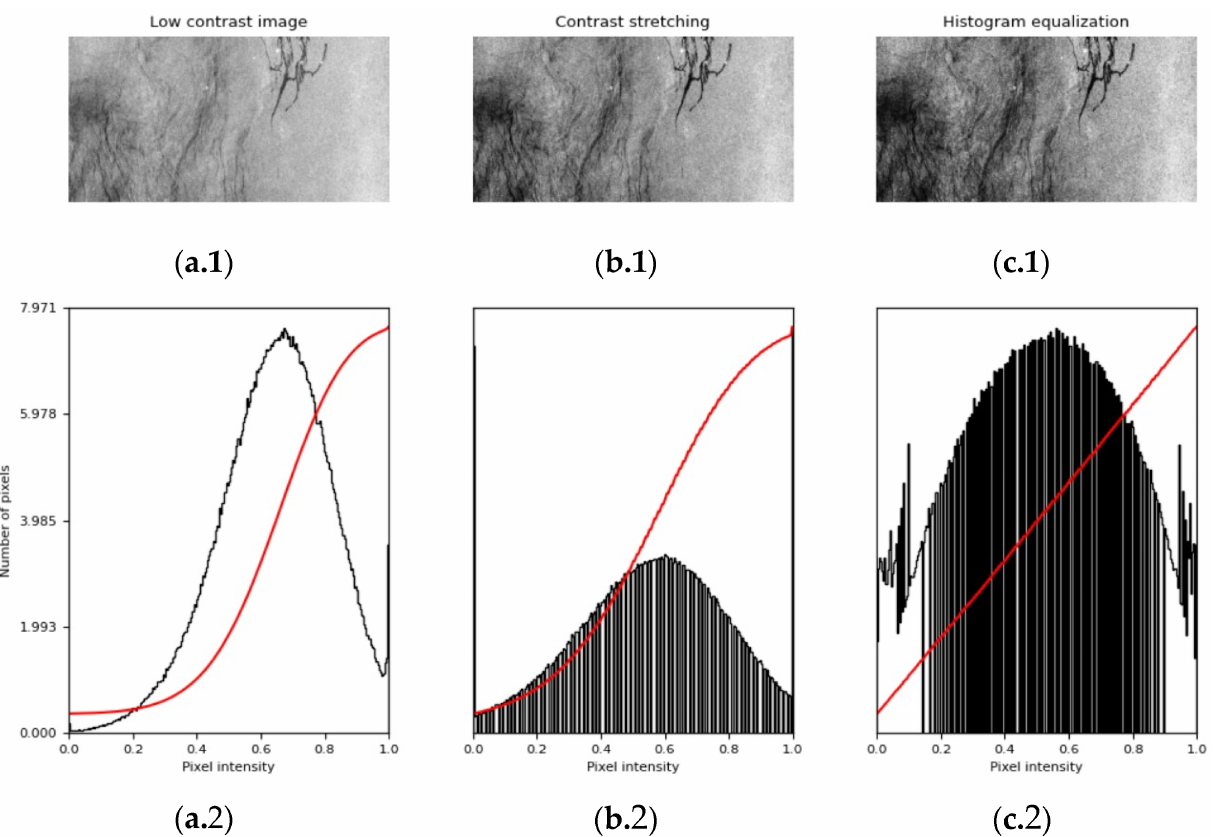
Figure 4. Filter comparison: ( a.1 ) original image; ( b.1 ) image with contrast stretching; ( c.1 ) image with histogram equalization. the second row contains image histograms (black) and the cumulative distribution function (red) of each case: ( a.2 ) original image; ( b.2 ) image with contrast stretching; ( c.2 ) image with histogram equalization. As can be seen, each filter affects the image histogram distribution